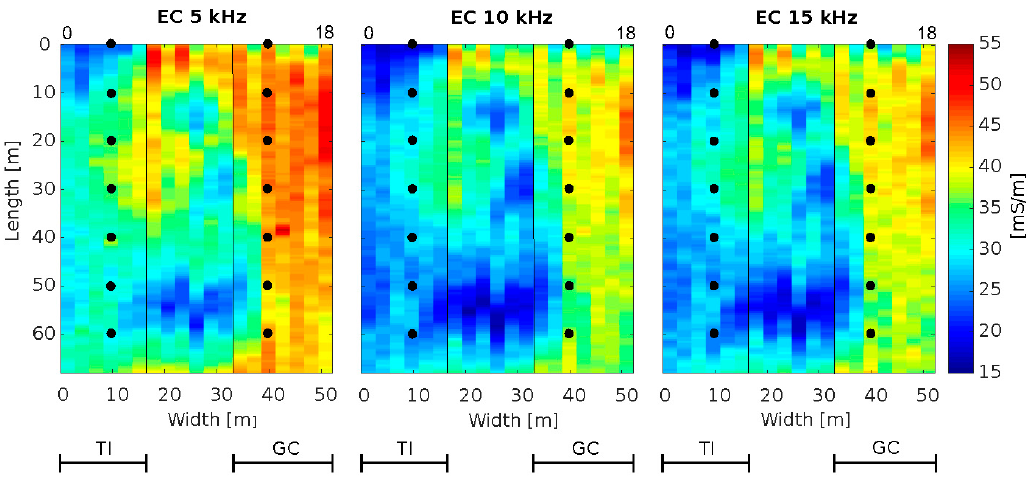
Figure 19. Carpeneto site, 21 March 2016. Electrical conductivity monitored by the EMI equipment and TDR probes locations (black dots) in the testing plot. The three images represent lower depths of investigation, from right to left.